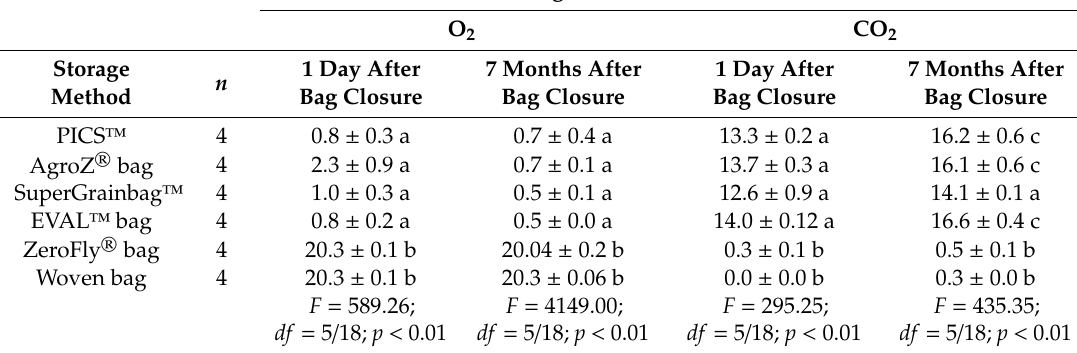
Table 4. Levels of O 2 and CO 2 in six types of storage bags filled with naturally infested maize stored for seven months in Parakou,